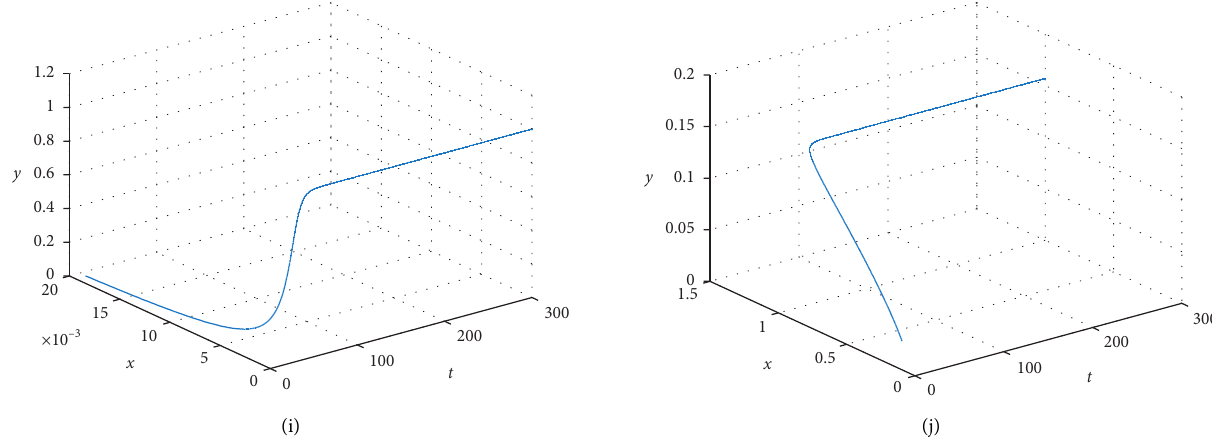
Figure 9: Simulated graph of vertical enterprises: (a) ① ; (b) ② ; (c) ③ ; (d) ④ ; (e) ⑤ ; (f) ⑥ ; (g) ⑦ ; (h) ⑧ ; (i) ⑨ ; (j) ⑩